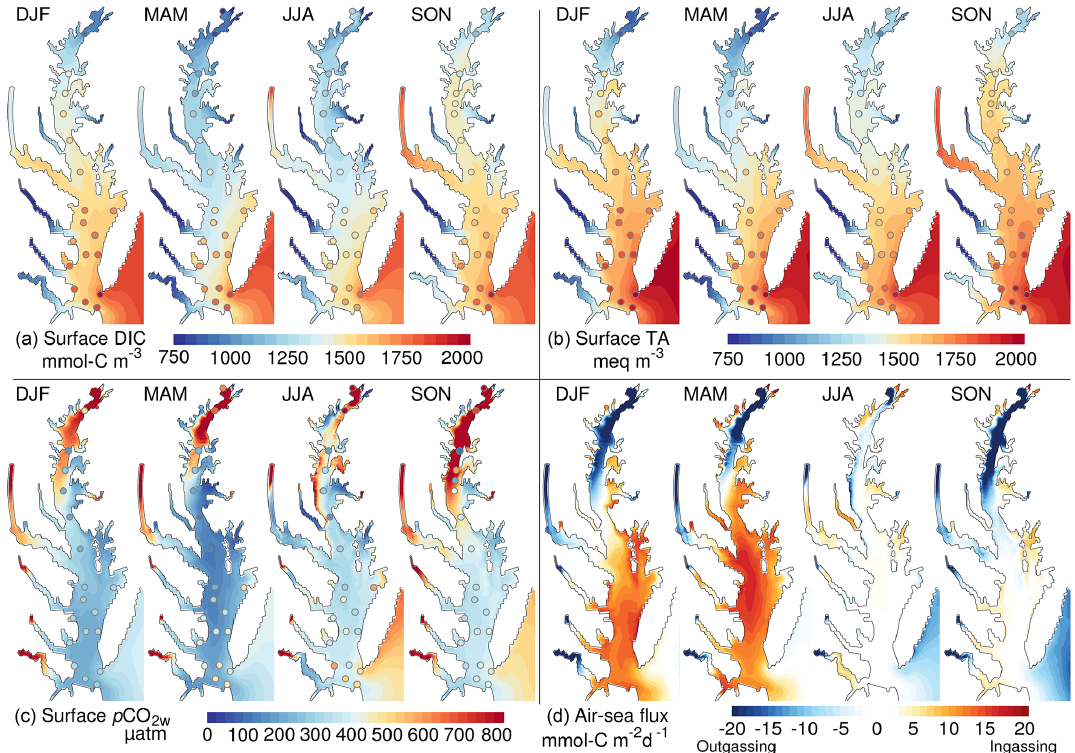
Figure 5. Overview of the spatial and seasonal variability of the inorganic carbon system: (a) surface dissolved inorganic carbon, (b) surface total alkalinity, (c) partial pressure of CO 2 at water surface and (d) air–sea CO 2 flux. The shading represents a seasonal climatology from the control experiment (years 2000–2014). The circles are derived from observations (see Methods section). DJF is December to February, MAM is March to May, JJA is June to August and SON is September to